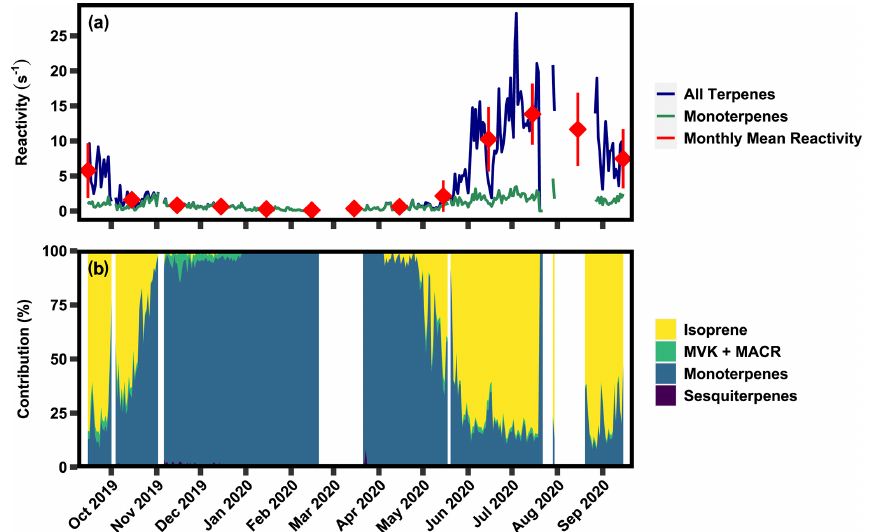
Figure 5. (a) Time series of 24h averaged calculated OH reactivity of all measured terpene classes and the monoterpene class, as well as the monthly mean of calculated OH reactivity. (b) Relative contribution of each of the BVOC classes to OH